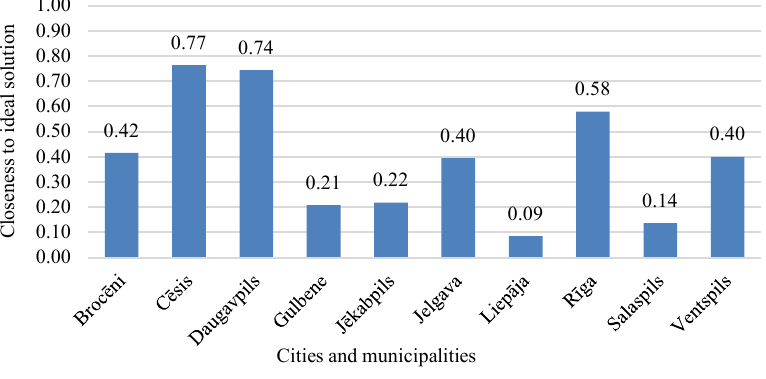
Fig. 3. Direct aspects TOPSIS and AHP evaluation results.